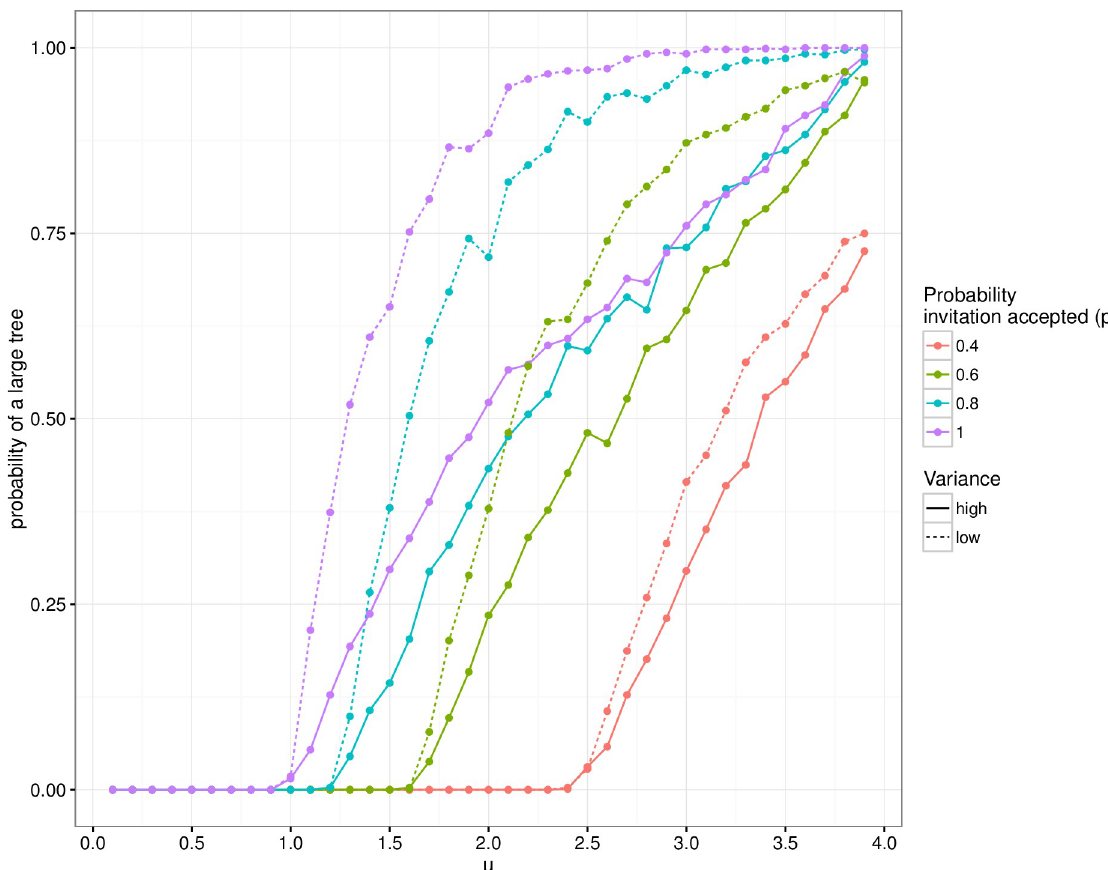
Fig 3. Increased number of invitations sent and probability of acceptance. Solid lines show probability of a large tree for different values of μ and a high σ 2 , as observed in the data (scenarios S5 to S9). The dashed lines show the same, but now assuming the lowest possible σ 2 for each μ (scenarios S10 to